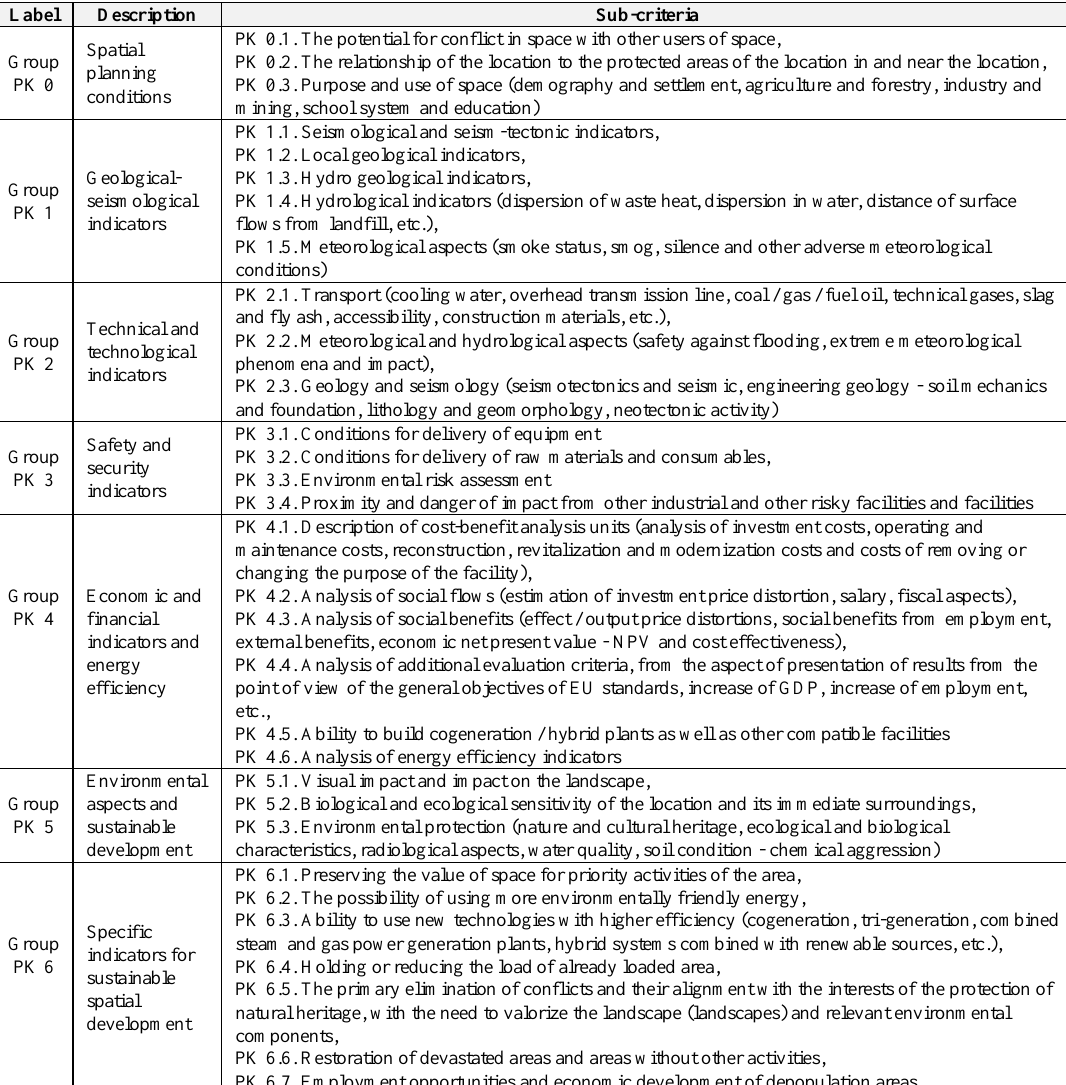
Table 2. Comparison criteria for selection of coal / gas / fuel oil TPP